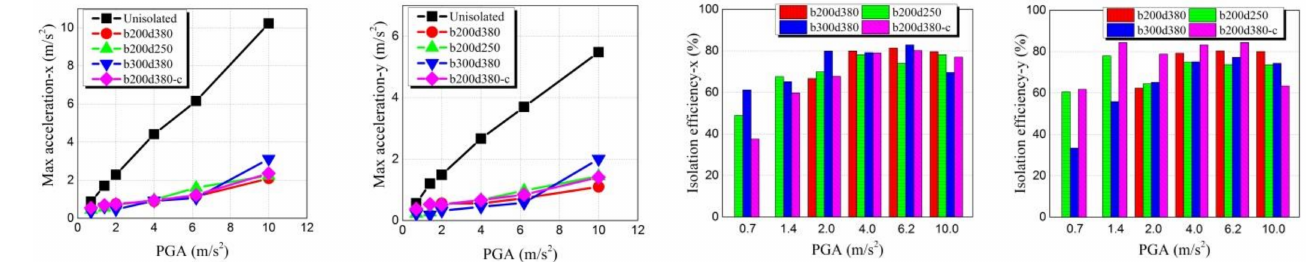
Figure 25. The maximum acceleration responses and isolation efficiency under Wo-long (high- frequency) ground motion.